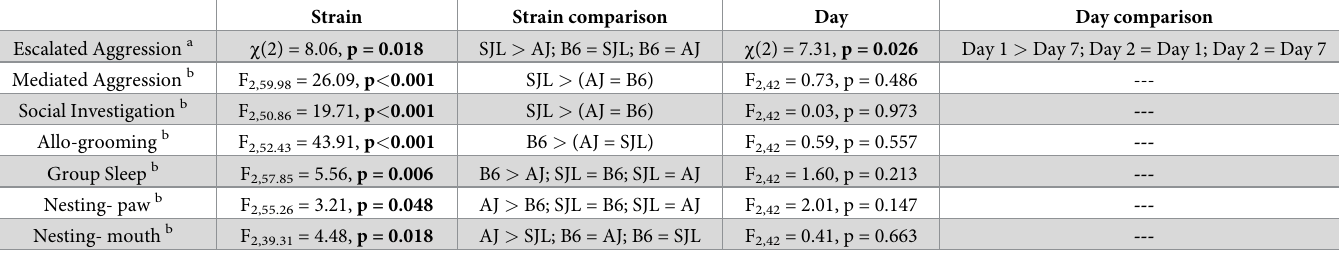
Table 4. Effects of strain and day on behaviors of interest based on mixed